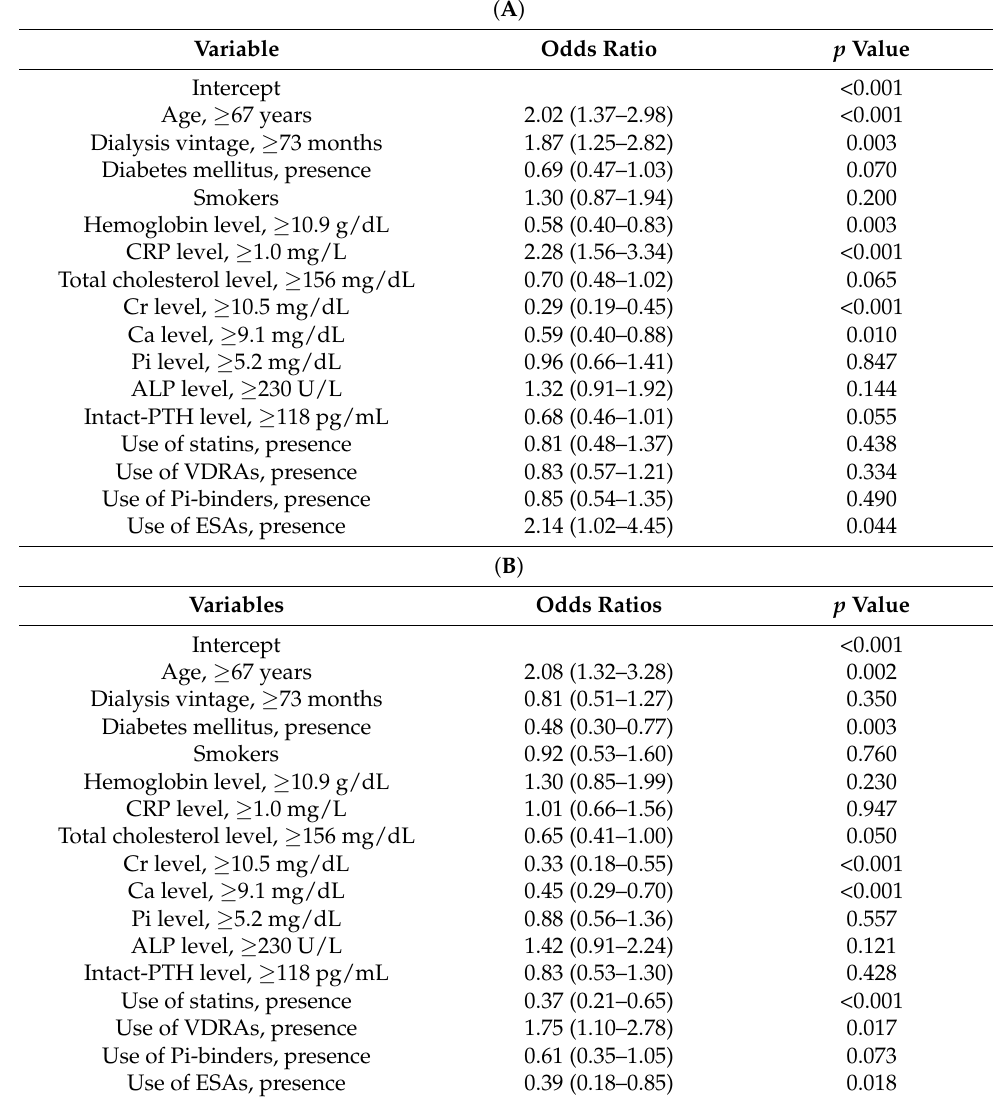
Table 2 ( A ): The adjusted R 2 of the model was 0.178. Table 2 ( B ): The adjusted R 2 of the model was 0.180. Categories for age, dialysis vintage, and levels of hemoglobin, CRP, total cholesterol, Cr, Ca, Pi, ALP, and intact- PTH were calculated in accordance with the median value of the group. Abbreviations: CRP, C-reactive protein; Cr, creatinine; Ca, calcium: Pi, phosphate; ALP, alkaline phosphatase; intact-PTH, intact parathyroid hormone; VDRAs, vitamin D receptor activators; ESAs, erythropoiesis-stimulating